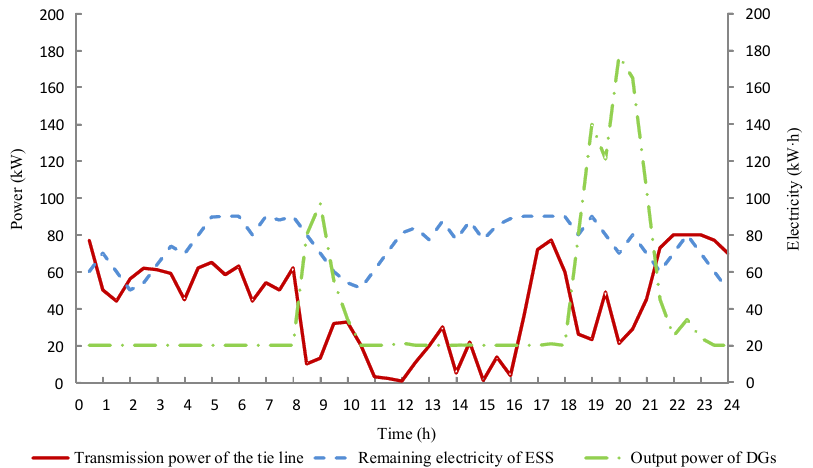
Figure 9. Optimal scheduling strategy of the typical day based on the conventional strategy.